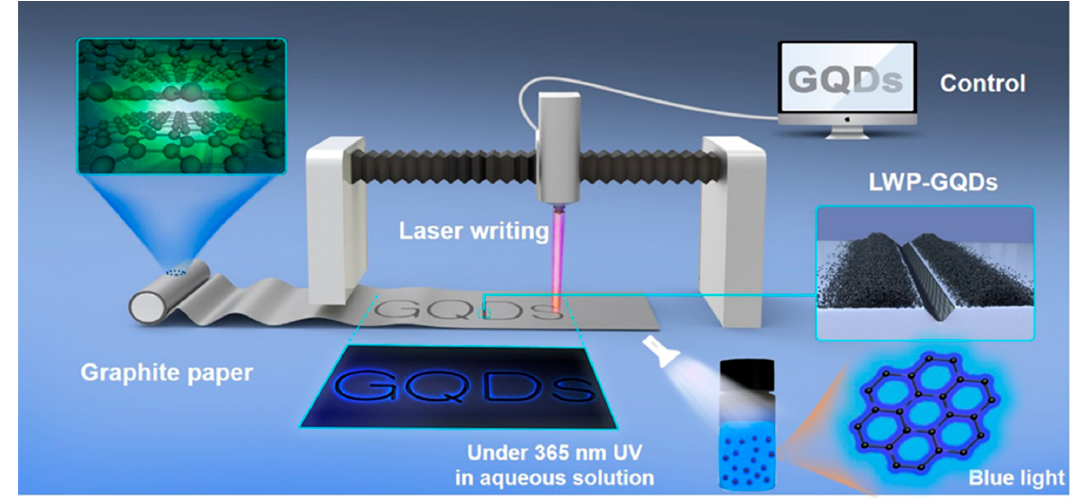
Figure 6. A schematic illustration for the generation of laser writing produced GQDs. Reprinted with permission from Ref. [52].